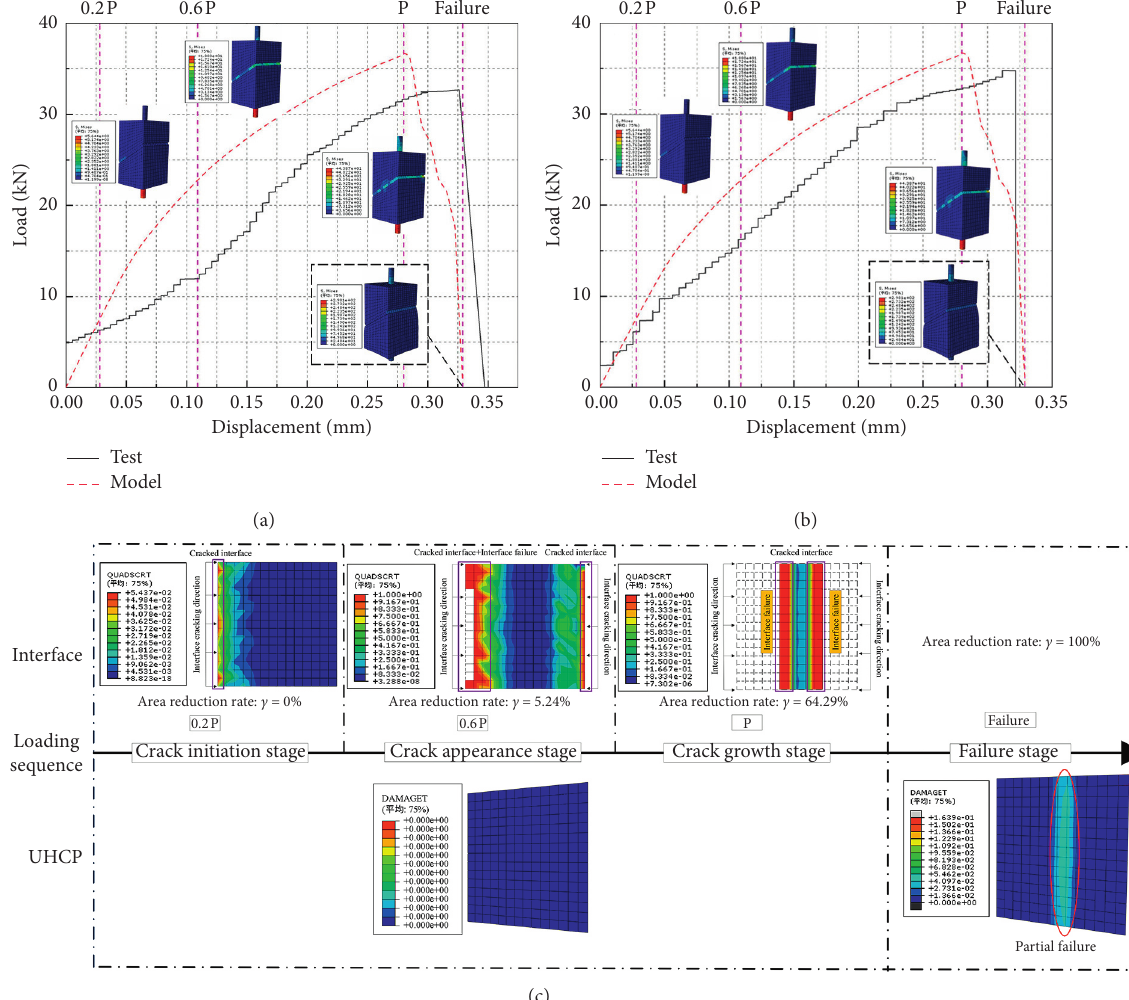
Figure 13: Comparison of experimental and model results. (a) Load-displacement curve of specimen ST-E-3. (b) Load-displacement curve of specimen ST-E-6. (c) Interface crack development and UHPC tensile